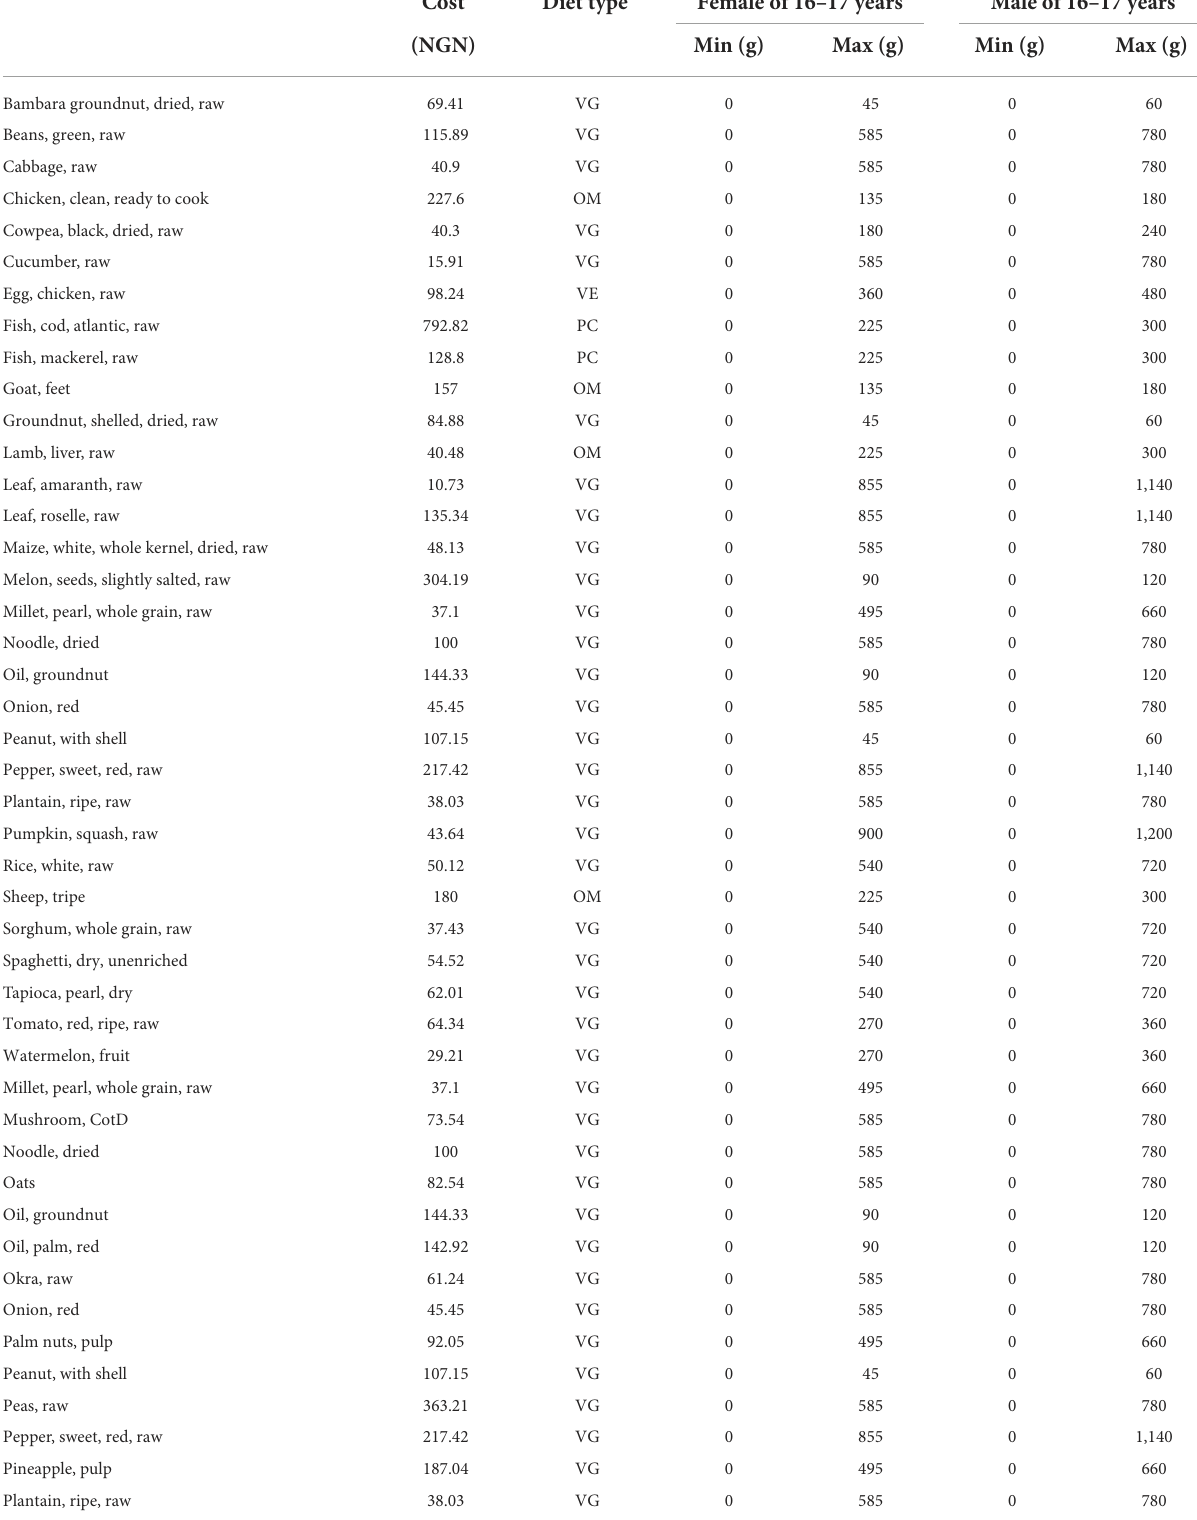
TABLE 3 Cost per 100 g ∗ in Nigerian naira (NGN) and daily allowed intake in grams for food commodities available in Ebonyi. Cost Diet type Female of 16–17 years Male of 16–17 years (NGN) Min (g) Max (g) Min (g) Max